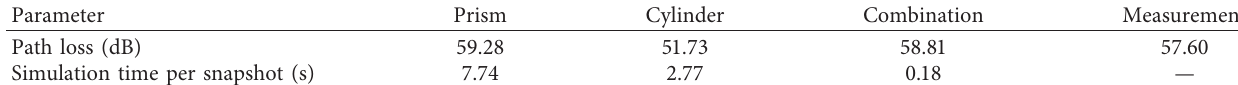
Figure 5: CDFs of the PL with the Tx and Rx in front of the torso. Table 6: Simulation and measurement results around the chest.